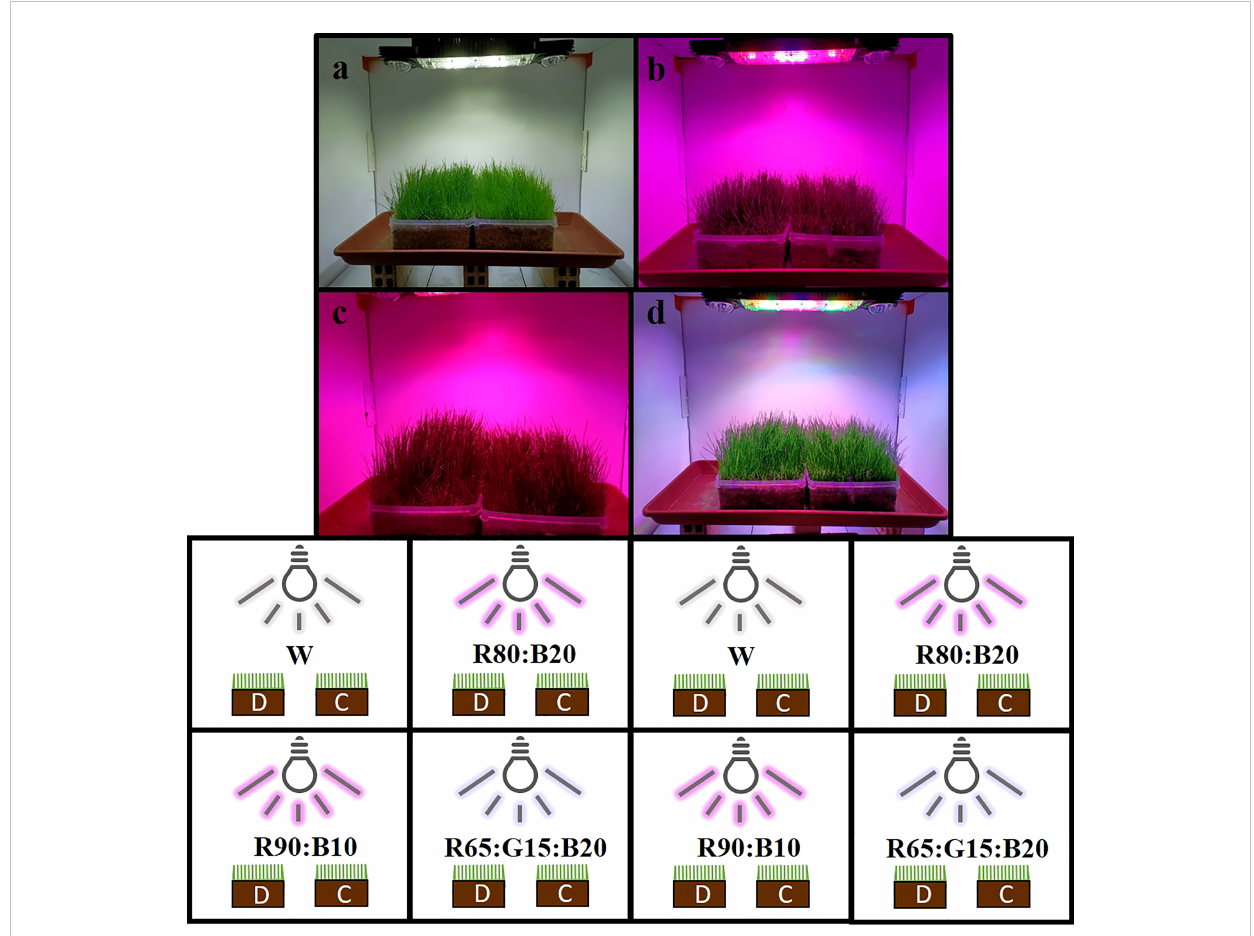
FIGURE 4 Schematic representation of the experiment 2. (A) 100% cool white (W); (B) 80% Red:20% Blue (R80:B20); (C) 90% Red:10% Blue (R90:B10); and (D) 65% Red:15% Green:20% Blue (R65:G15:B20) on Double (D) and Capri (C)